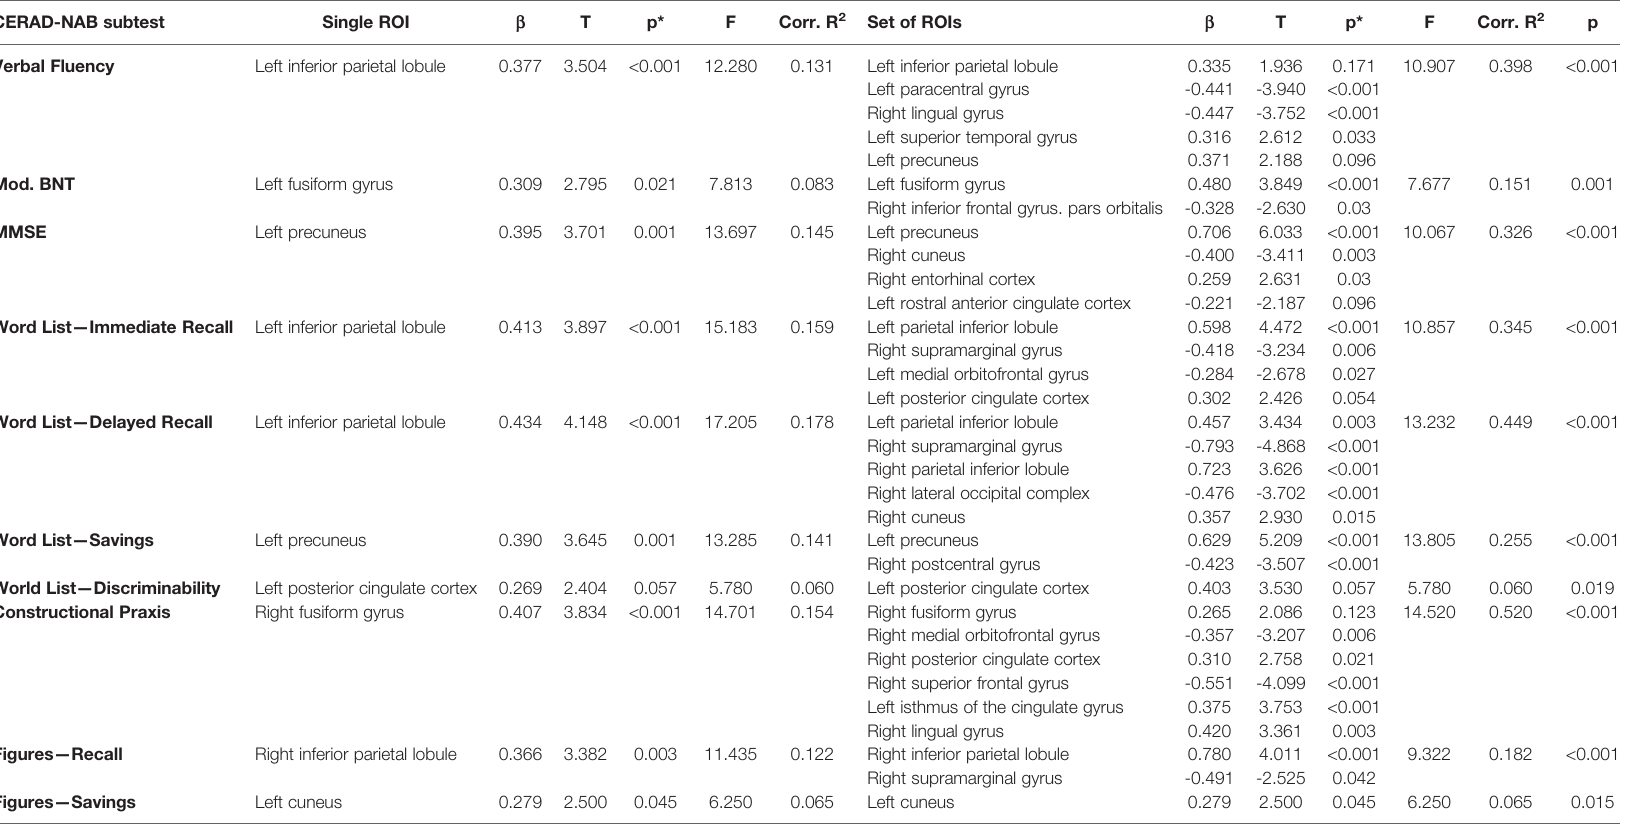
RelationshipbetweenregionalcorticalthicknessasmeasuredbystructuralMRIandcognitiveperformanceasmeasuredbyz-scoresonCERAD-NABsubtests.Coef fi cientsofdeterminationaregivenforthesinglemostpredictiveROIandaset of most predictive ROIs with regard to CERAD-NAB subtests performance. P-values are Bonferroni corrected (*) for testing three different biomarkers. b ,standardizedregressioncoef fi cient; CERAD-NAB, ConsortiumtoEstablisha RegistryforAlzheimer ’ sDisease — NeuropsychologicalAssessmentBattery; Corr.,corrected;MMSE, Mini-MentalStateExamination; MRI,MagneticResonance Imaging; ROI, region of